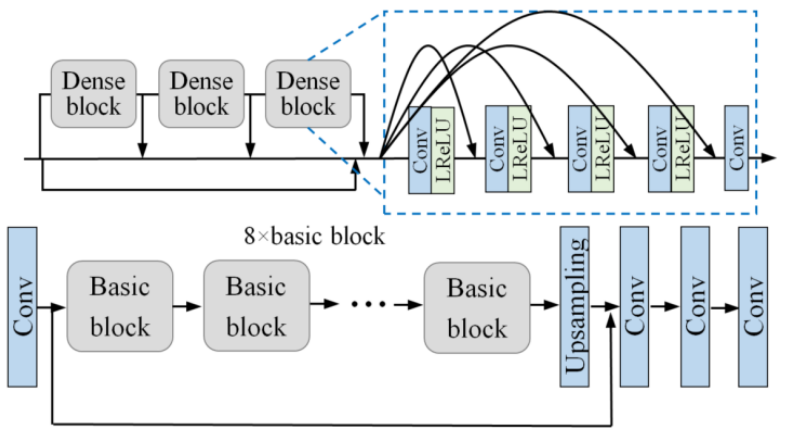
Figure 6. Structure of ESRGAN.